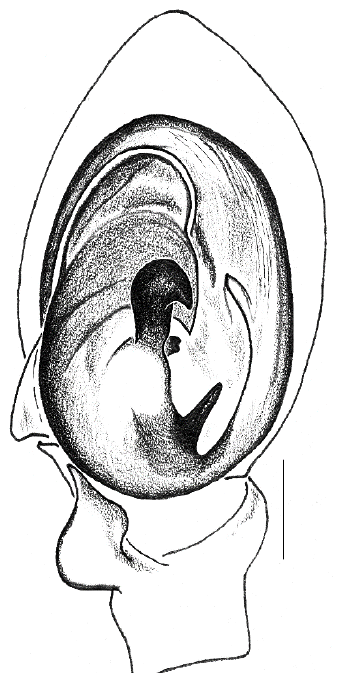
Fig. 1. Male palp of Xysticus lanio C. L. Koch, 1835 (ventral view). Scale bar – 0.1